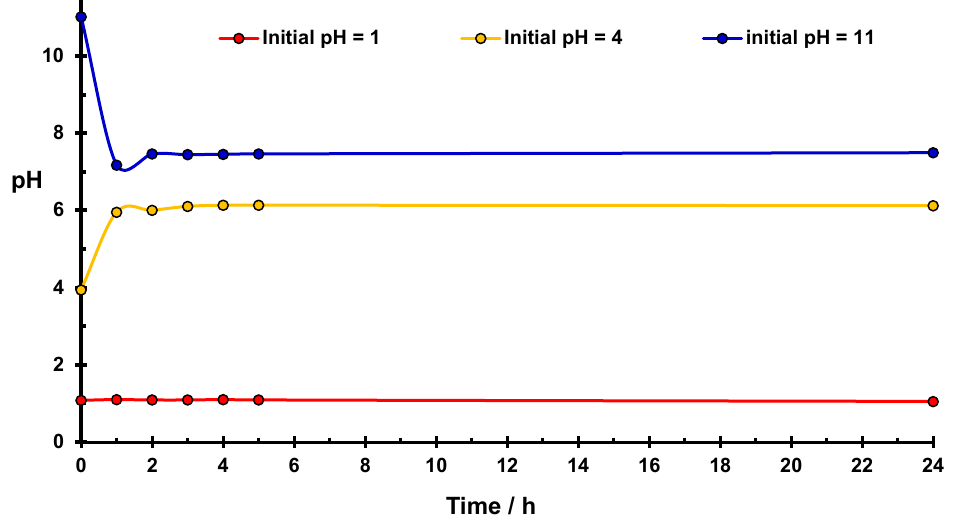
Figure 3. Changes of pH for the starch suspension in water as a function of time. Conditions: 1 g of the phosphorylated starch in 22.5 cm 3 of water at room temperature.